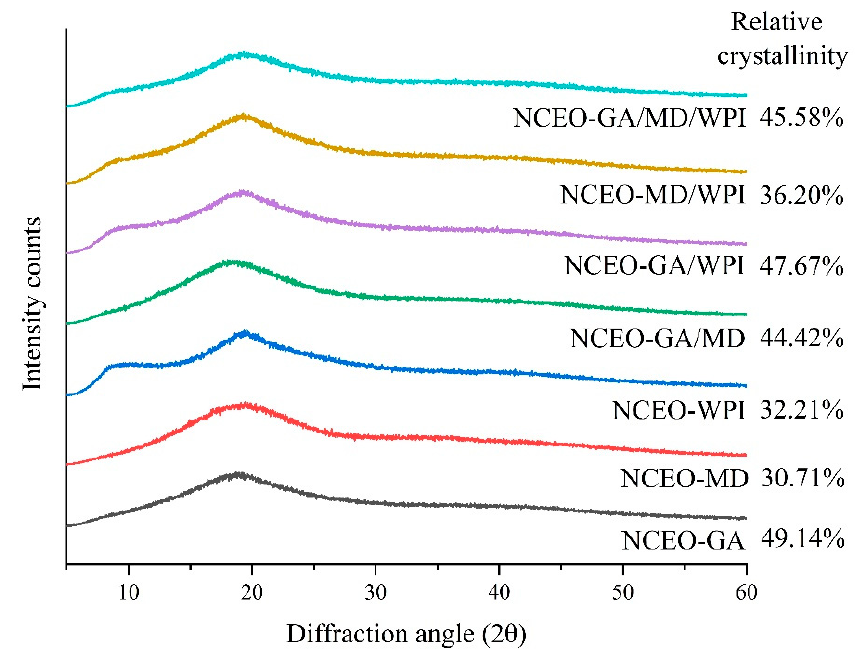
Figure 2. XRD diffraction patterns of the CEO nanocapsules.